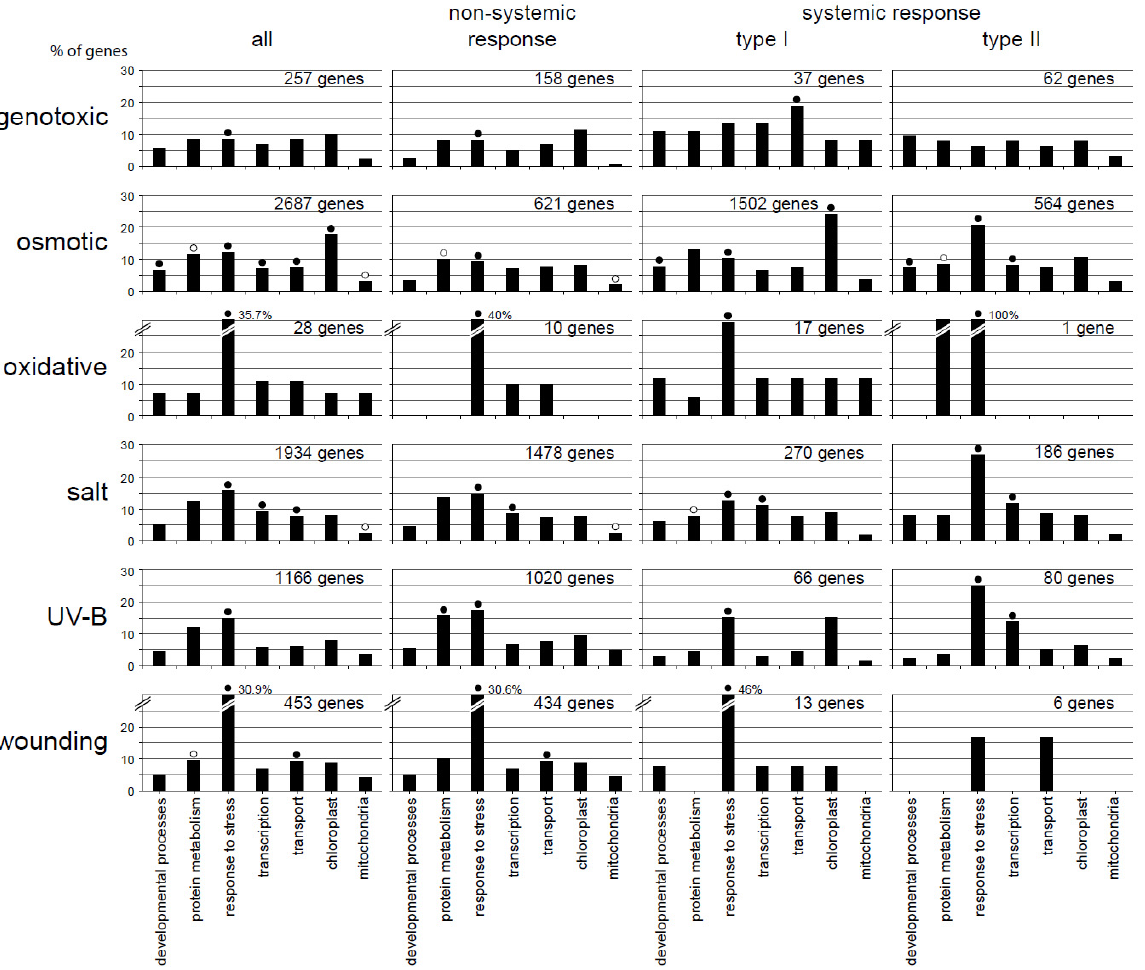
Figure 2. Functional categorization according to the gene ontology (GO) terms. Genes involved in non-systemic, type I systemic or type II systemic responses during the six systemic abiotic stress treatments are categorized for significant over ( ● )- or under ( ○ )-representation ( p ≤ 0.01). Percentages of genes categorized into the seven well-annotated GO terms “developmental processes”, “protein metabolism”, “responses to stress”, “transcription”, “transport”, “chloroplast”, or “mitochondria” are given for each of the six stress responses. Number of genes, observed GO counts and p -values can be found in Table